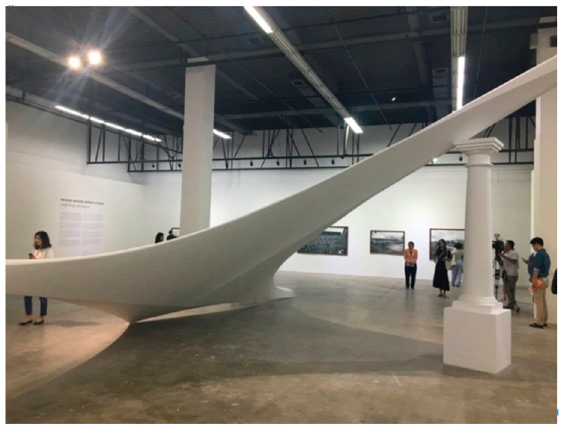
Figure 7. Lais Myrrha, Case Study , 2018, replicas 1:1 of columns in plaster, installation at Gwangju Biennale, courtesy of the artist.